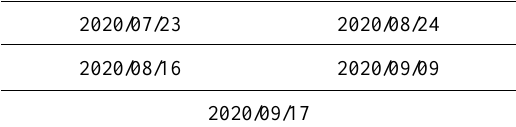
Table 1 . Data acquisition